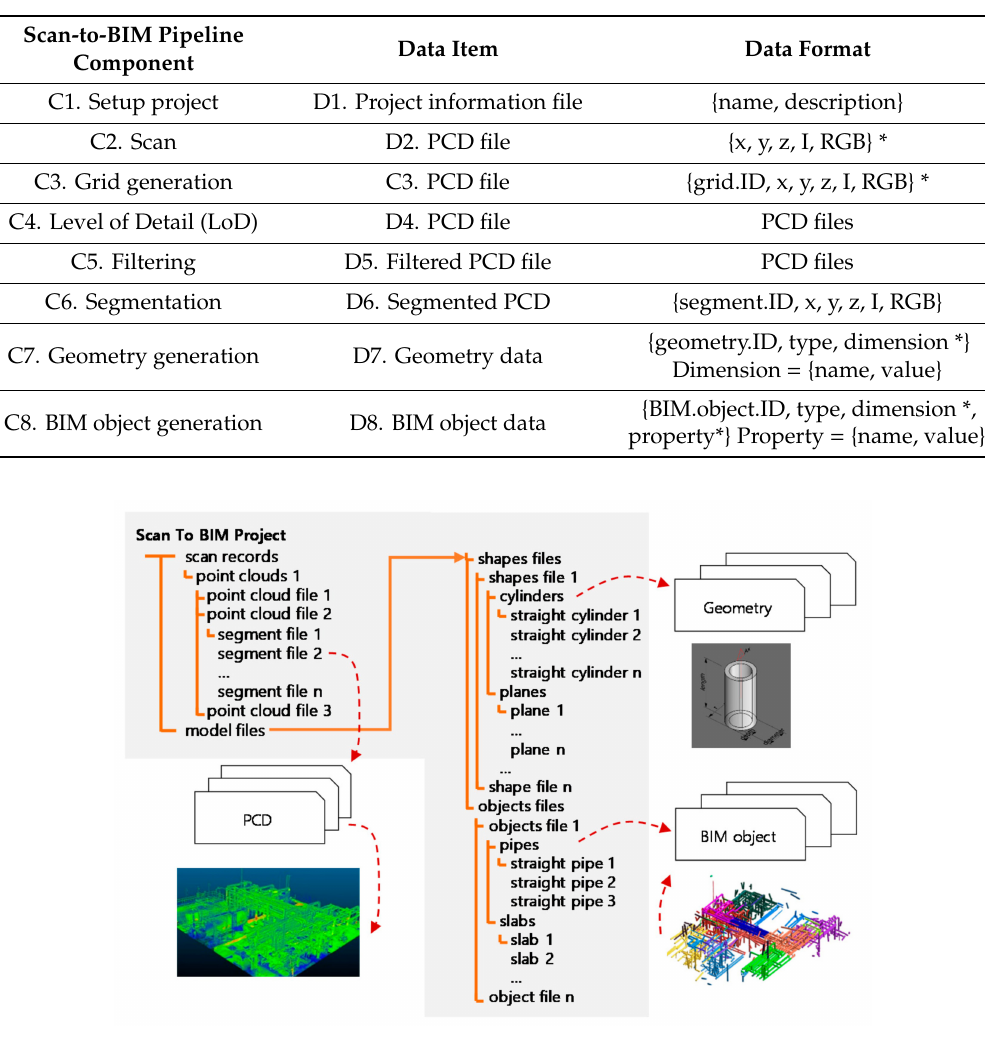
Figure 4. Scan-to-BIM Pipeline Component Dataset Hierarchy Structure